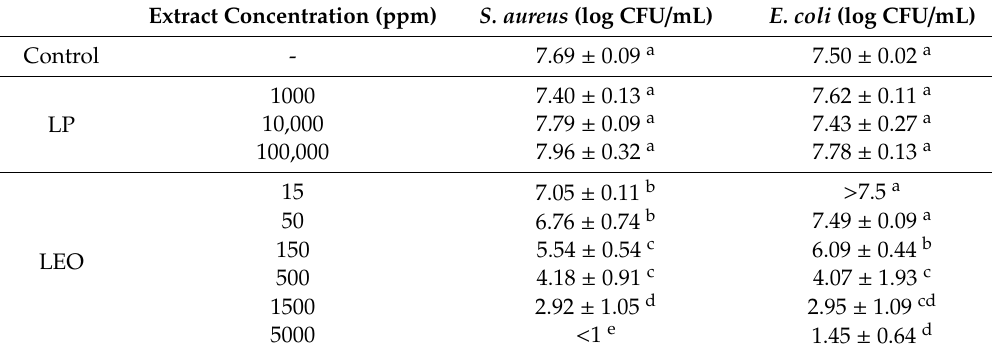
Table 5. Antimicrobial performance of LP and LEO against Staphylococcus aureus and Escherichia coli . Results are shown from triplicate samples after an initial inoculum size of 5.72 ± 0.26 and 5.80 ± 0.01 log colony-forming units (CFU) / mL, respectively. Mean ± SD, n = 3. Di ff erent superscripts in the same column values for each lemon additive indicate statistically significant di ff erent values compared to the control ( p <